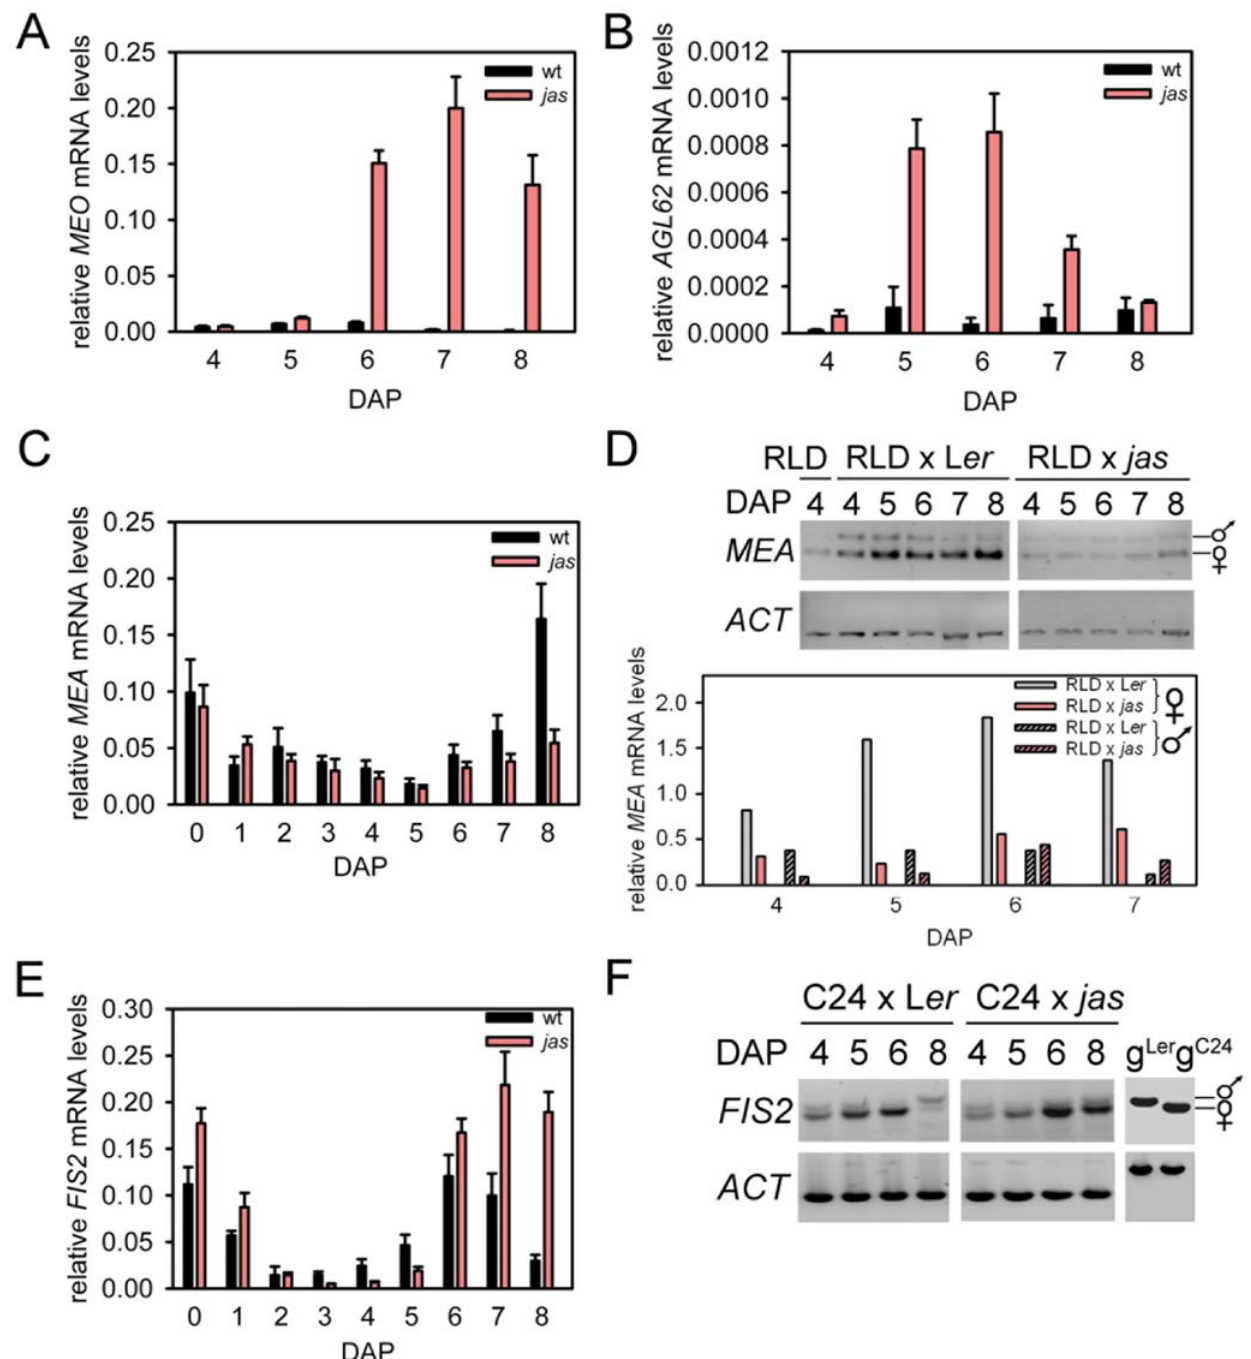
Figure 6. Increased expression of FIS target genes and decreased MEA mRNA levels in triploid seeds. Quantitative RT–PCR analysis of MEO (A) and AGL62 (B) expression in wild-type and jas seeds. Error bars, s.e.m. (C) Quantitative RT-PCR analysis of MEA expression in wild-type and jas seeds. Error bars, s.e.m. (D) Allele-specific MEA transcript levels were determined after crosses of RLD with wild type (L er ) or jas plants. Quantified results are shown in lower panel. (E) Quantitative RT-PCR analysis of FIS2 expression in wild-type and jas seeds. Error bars, s.e.m. (F) Allele-specific FIS2 transcript levels were determined after crosses of C24 with wild type (L er ) or jas plants. DAP; days after pollination. wt; wild type.